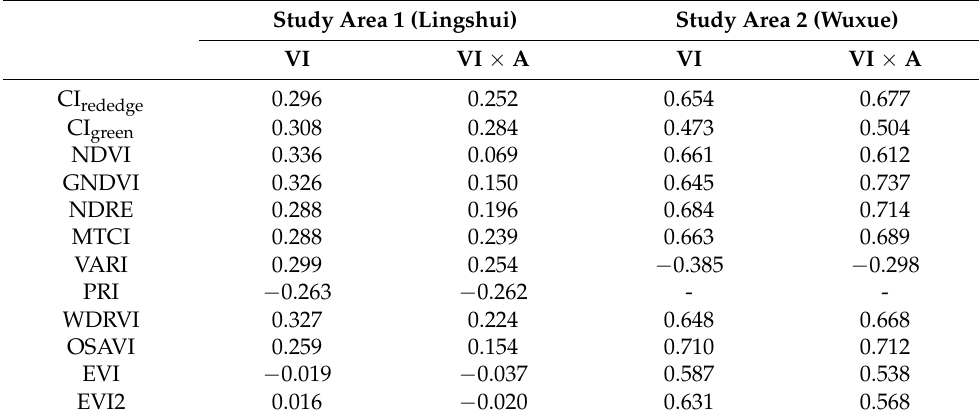
Table 5. The Pearson correlation coefficients of yield with VI and VI × A at heading